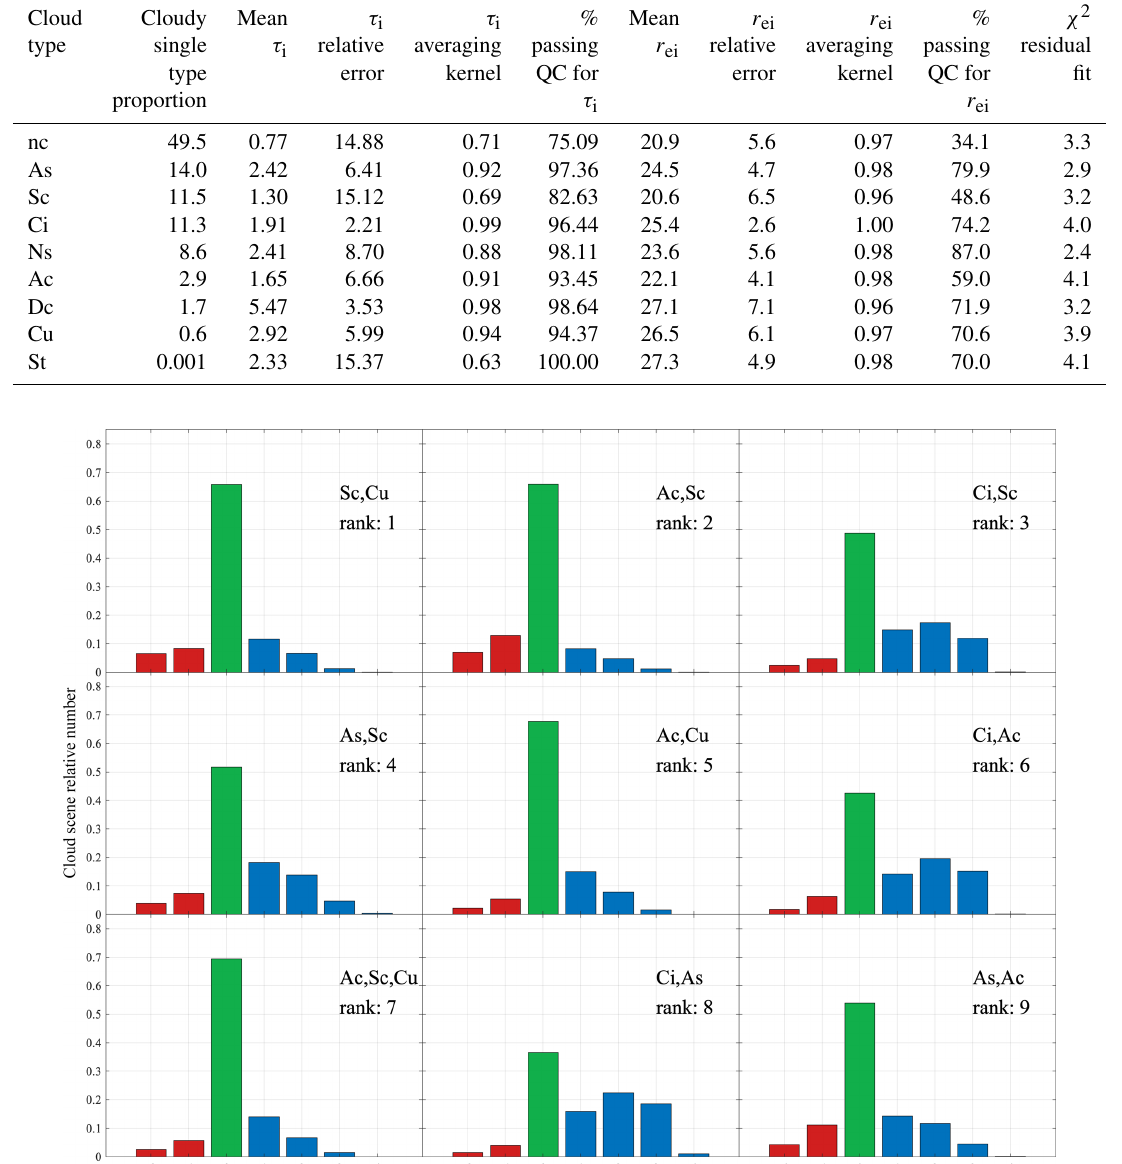
Table 3. Cloud ice properties for cloudy sky with one cloud type (i.e., all CloudSat profiles have the same cloud type). Proportions and relative errors are in percent. The effective radius is in micrometers (µm).